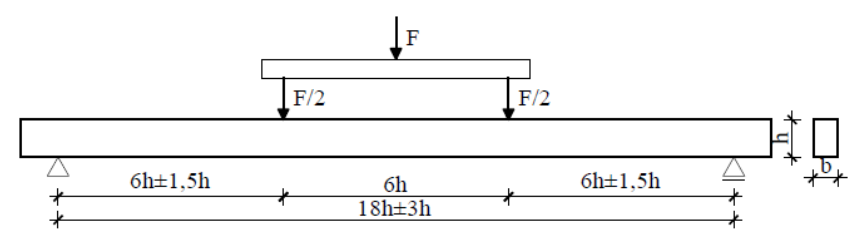
Figure 11. View of an example beam in each series: ( a ) series E — with 2 drawbolts (double-sided tooth plate connectors type C10 + M10 screws), ( b ) series F — with wood inserts (and additional steel clamps), ( c ) series G — with steel clamps.